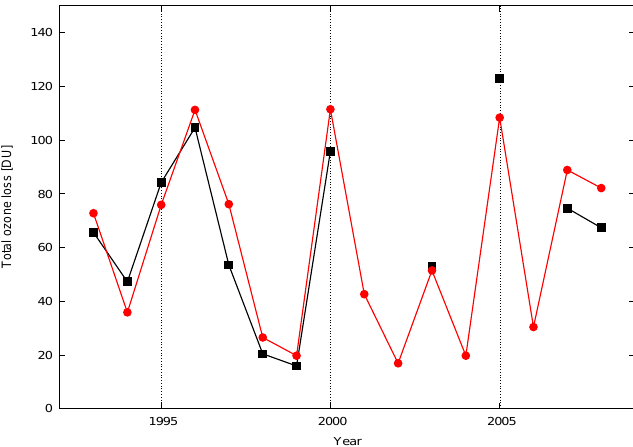
Figure 5. Year-to-year variability in total chemical ozone loss in the Arctic estimated from SWIFT (red) compared with observations (black; Rex et al.,